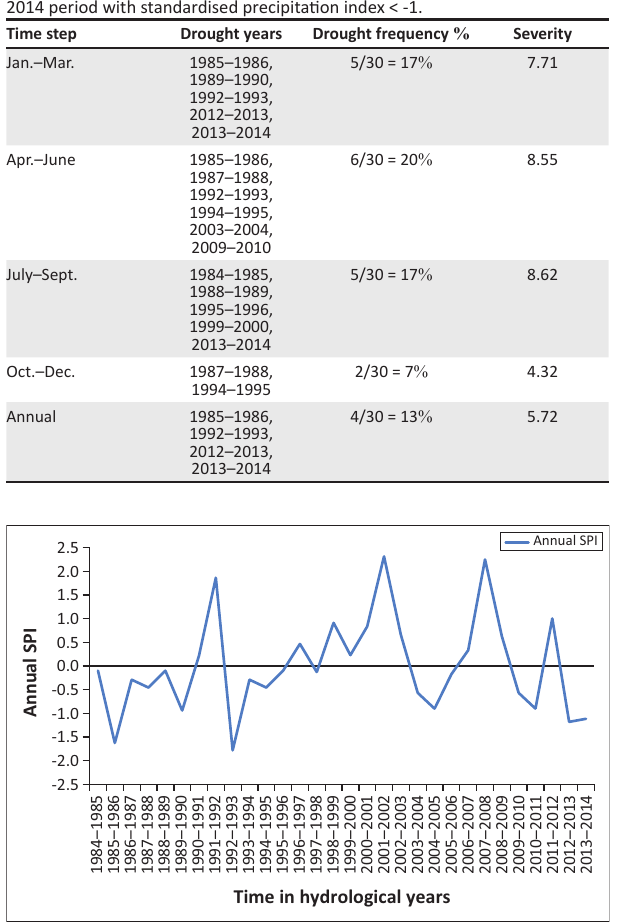
FIGURE 6: Annual standardised precipitation index: 1984–2014.